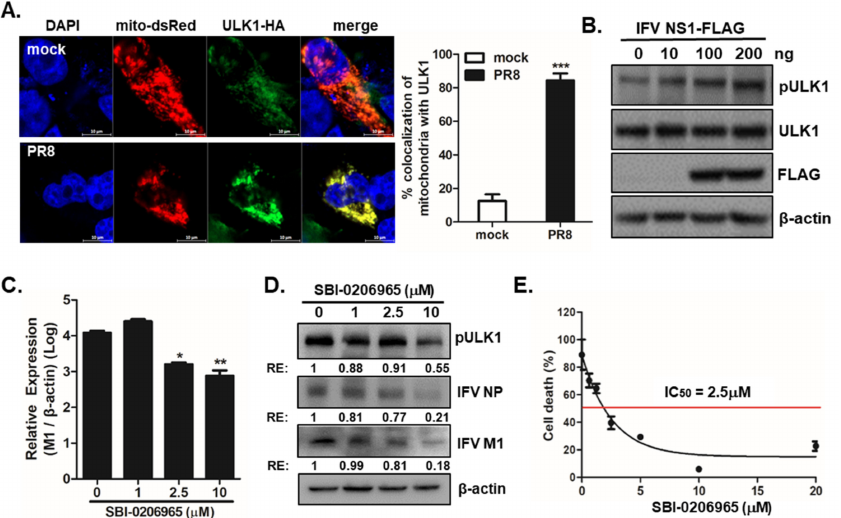
Figure 4. ULK1 is important for mitophagy and IFV replication. ( A ) A549 cells transfected with mito-dsRED (red) and ULK1-HA (green) plasmid were infected with PR8 virus at an MOI of 1 for 24 h. ULK1 was detected with rabbit anti-HA tag antibody, followed anti-rabbit FITC-conjugated antibody. Scale bar = 10 µ m. ( B ) Phosphorylation of ULK1 was evaluated in A549 cells transfected with IFV NS1-FLAG plasmid for 24 h and treated with CCCP for 2 h by immunoblot analysis. ( C – E ) A549 cells were pretreated with different concentrations of SBI and infected with PR8 virus at an MOI of 1 for 24 h. ( C ) The IFV M1 copy number was quantitated by qRT-PCR, normalized, and analyzed (means ± SD; n = 3). * p < 0.05; ** p < 0.01, *** p < 0.001, vs. DMSO-treated cells. ( D ) IFV NP and IFV M1 protein expression was measured by immunoblot analysis following treatment with the indicated doses of SBI ( E ). The 50% inhibitory concentration (IC50) of SBI was determined using the 4-parameter logistic nonlinear regression model equation in GraphPad Prism